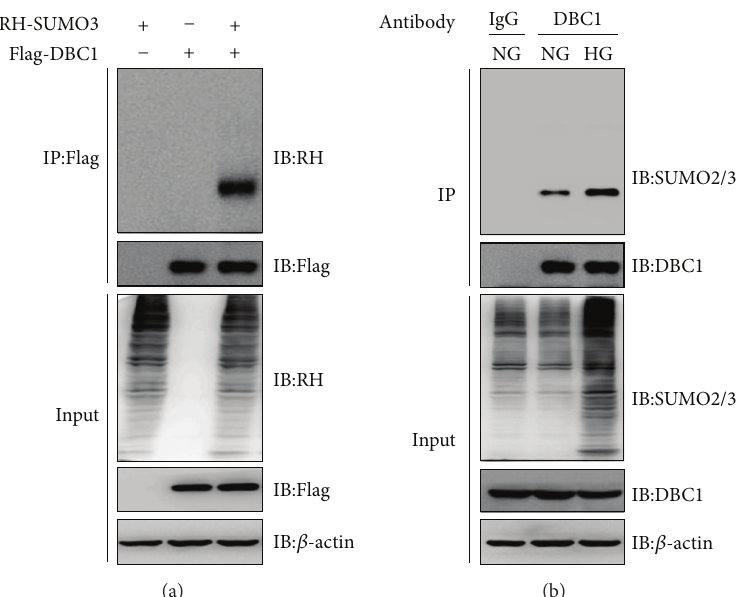
Figure4:HighglucoseinducedDBC1sumoylationinBRPCs.(a)AfterHEK293TcellsweretransfectedwithFlag-DBC1,withorwithoutRH- SUMO3 as indicated for 48 h, cell lysates were subjected to immunoprecipitation with anti-Flag antibody followed by immunoblot analysis. (b) BRPCs were treated with normal (NG) or high glucose (HG) for 48 h. Their lysates were subjected to immunoprecipitation with IgG or anti-DBC1 antibody followed by immunoblot analysis.